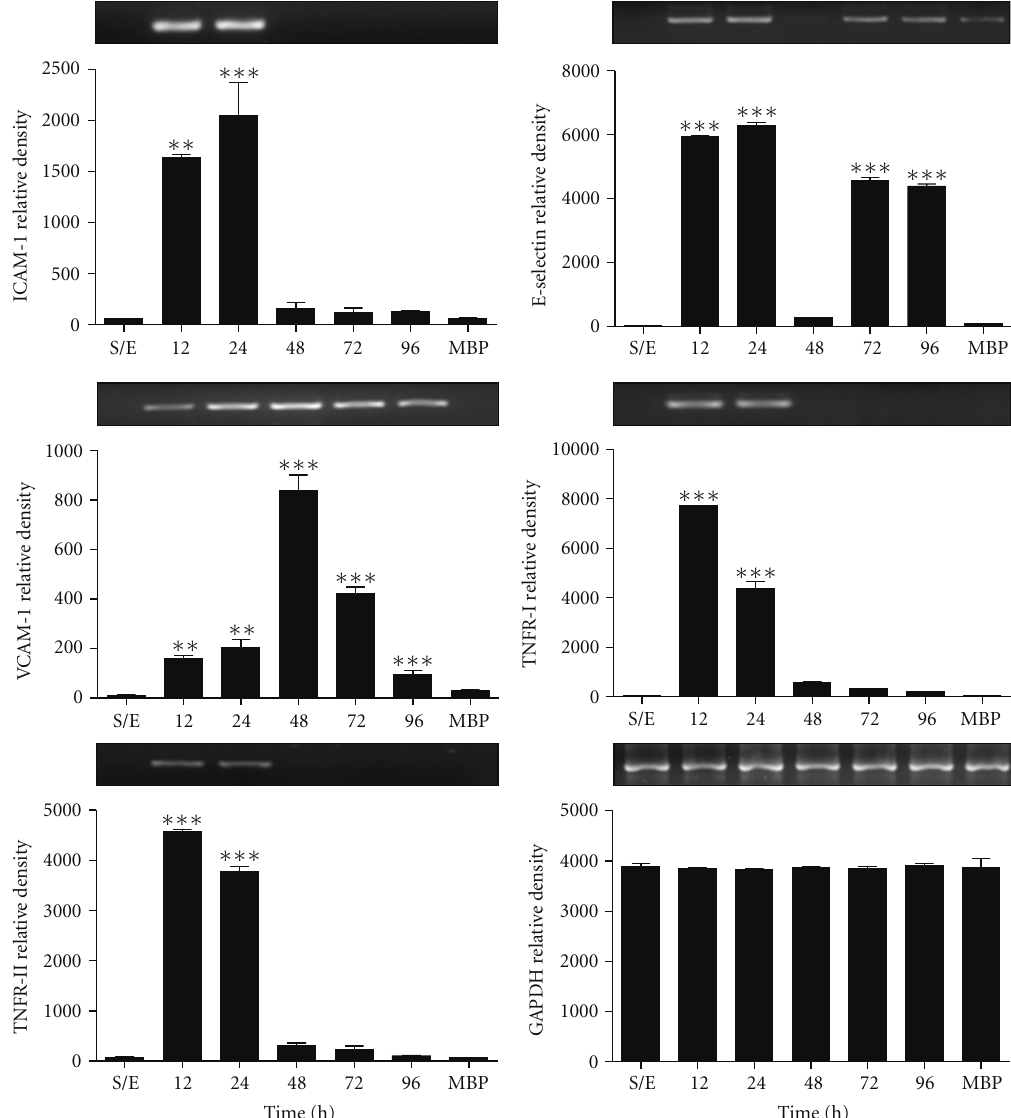
Figure 4: E ff ect of rMBP::SSP4 on gene expression of CAMs and TNFRs in PBMCs. RT-PCR analysis of CAMs and TNFRs mRNAs in PBMCs was performed as described (see Section 2). PBMCs were stimulated with the protein for 12–96 h, S/E (nonstimulated). The intensities of each band were quantified and plotted from the gels that are on top of each graph corresponding to the expression of genes. GAPDH was used as a control housekeeping gene. ∗∗ , ∗∗∗ P < 0 . 001 and 0.0001, respectively, versus unstimulated cells.